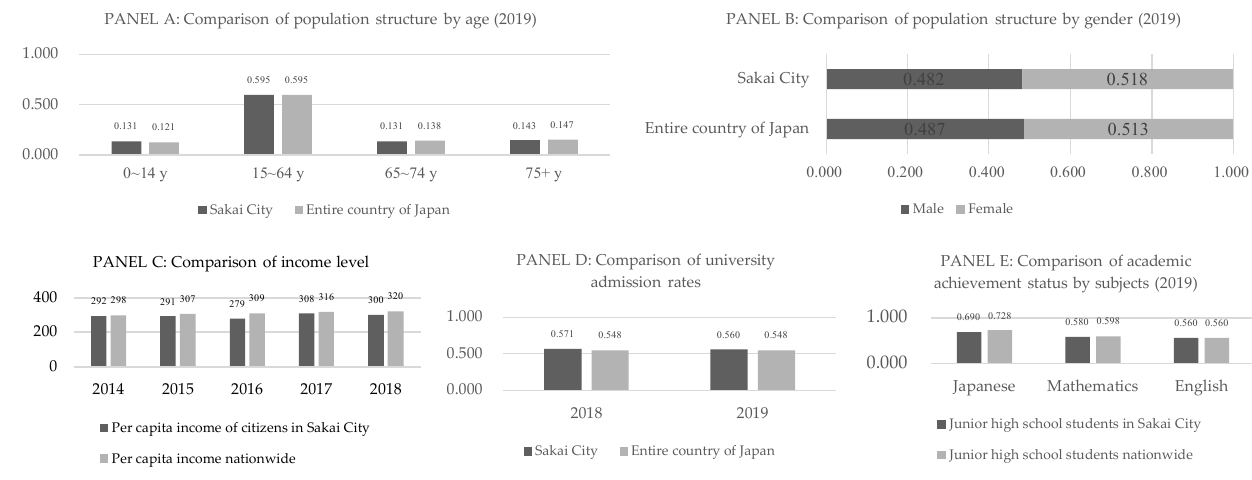
Figure 5. A comparison of Sakai City and the country as a whole in terms of population composition, income, and education level. Data source: Panels ( A , B ): Sakai City, Basic Resident Register (including foreign residents, by age and area) (2019) [21]; Statistics Bureau of Japan, Annual Report of Population Estimates (2019) [22]. Panel ( C ): Sakai City, Economic Calculation of Sakai Citizen (2018) [23]; Cabinet Office, Annual Report on National Accounts (2018) [24]. Panel ( D ): Ministry of Education Culture Sports Science and Technology of Japan, School Basic Survey (2019) [25]. Panel ( E ): National Institute for Educational Policy Research of Japan, National Assessment of Academic Ability Survey (2019) [26].